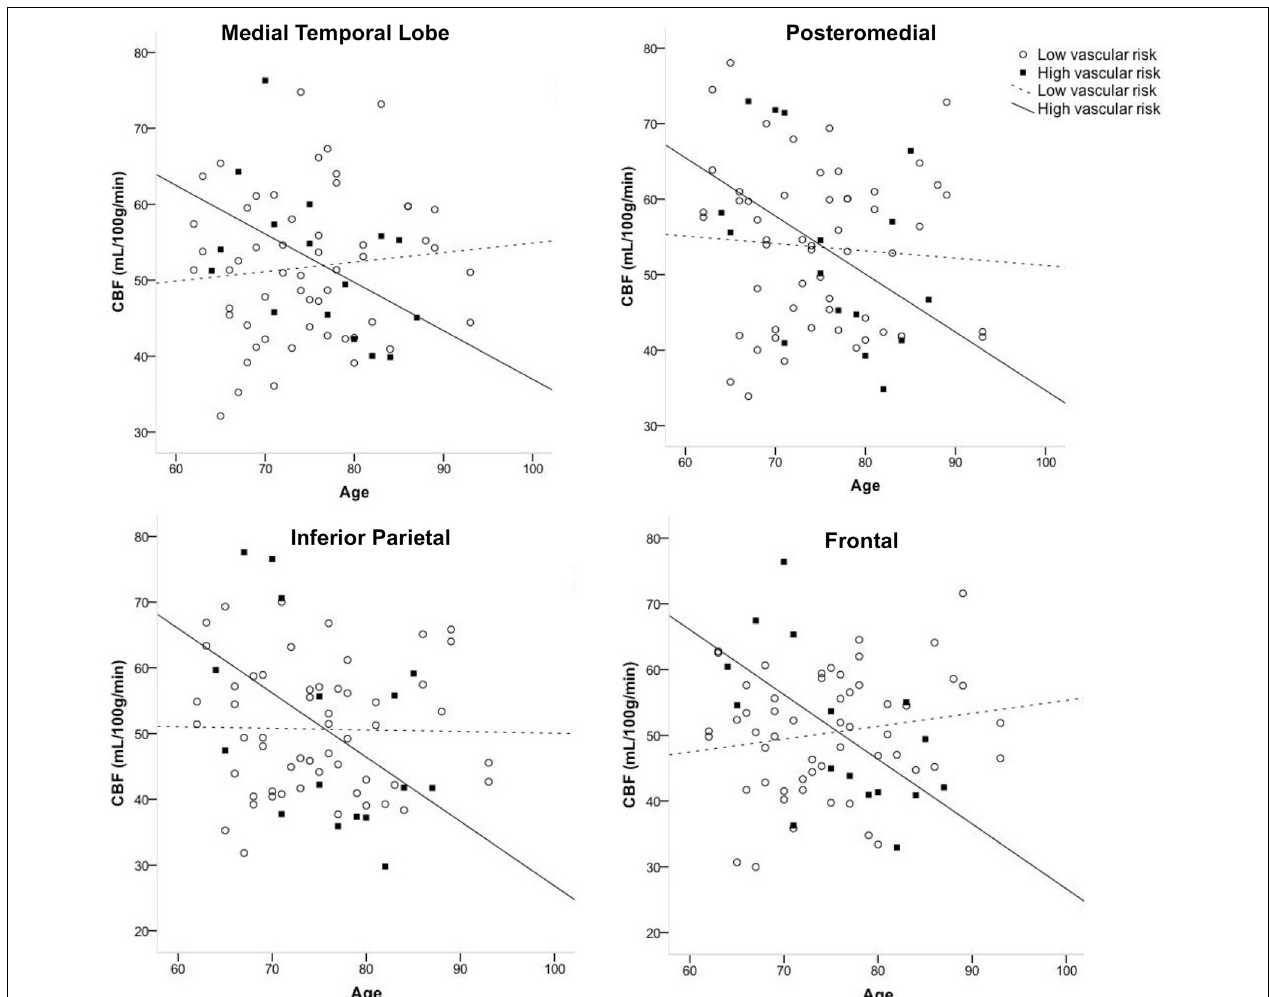
FIGURE 1 | Interaction of age and vascular risk burden on cerebral blood flow (CBF) for four a priori cortical regions of interest. Interactions were statistically significant for the medial temporal, inferior parietal, and frontal regions of interest ( p -values < 0.05) and there was a